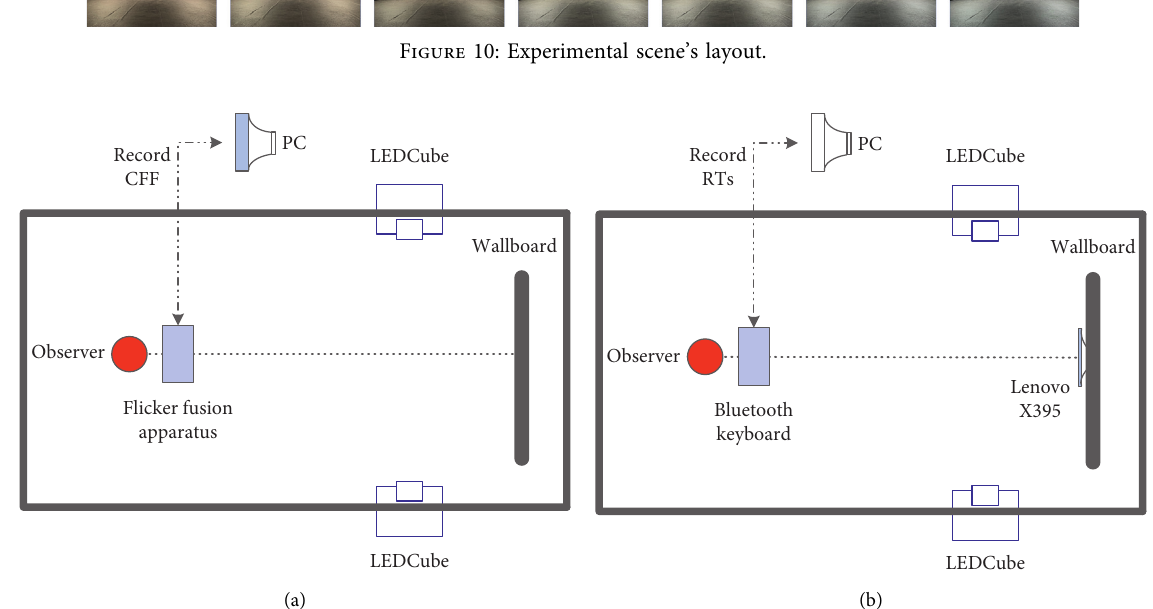
Figure 11: Schematic diagram of the experimental scene. (a) CFF. (b) Reaction time.